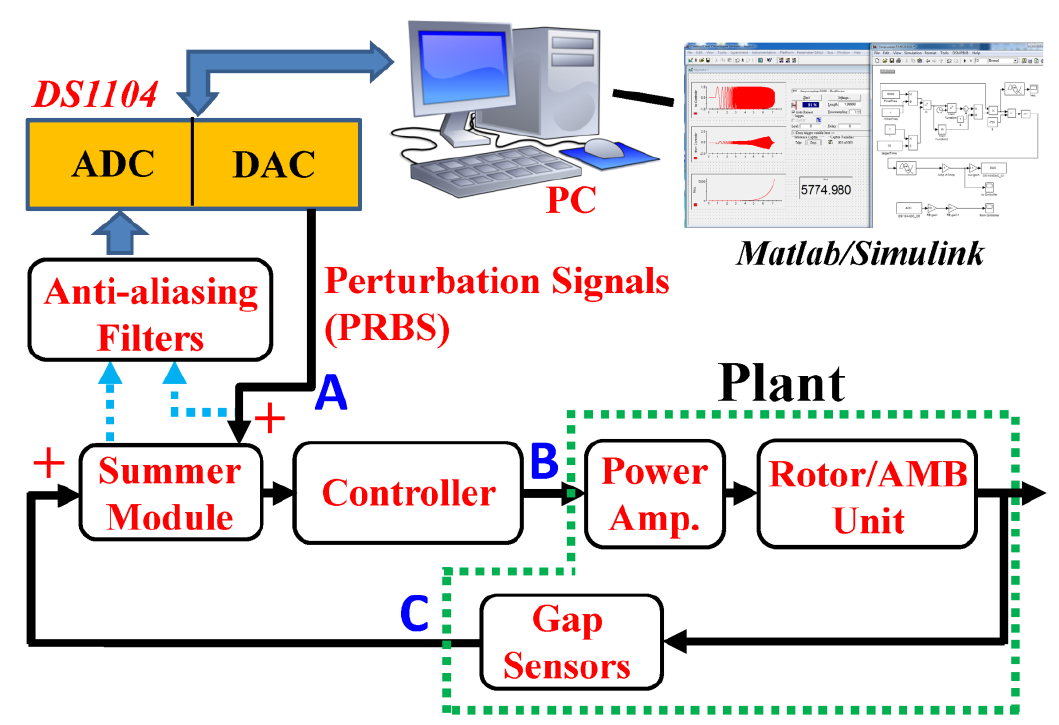
Figure 9. Schematic diagram of experimental setup for identification of rotor/AMB dynamic model.